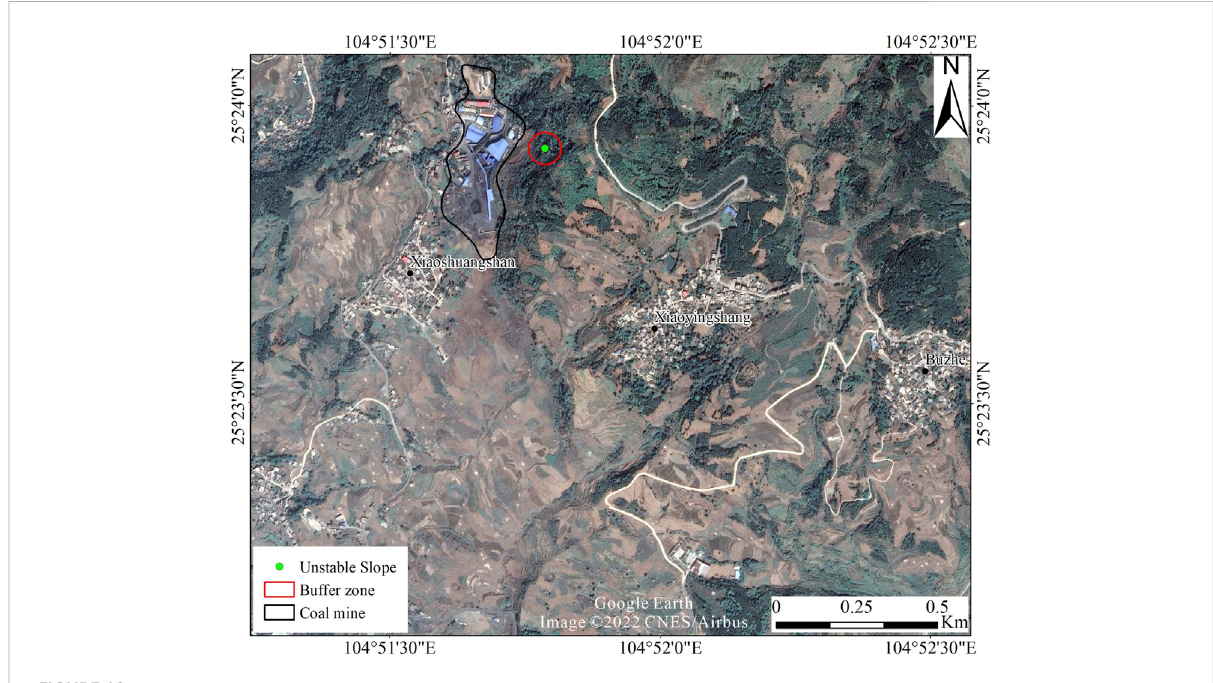
FIGURE 10 Location of the monitored unstable slope, coal mine, and built buffer